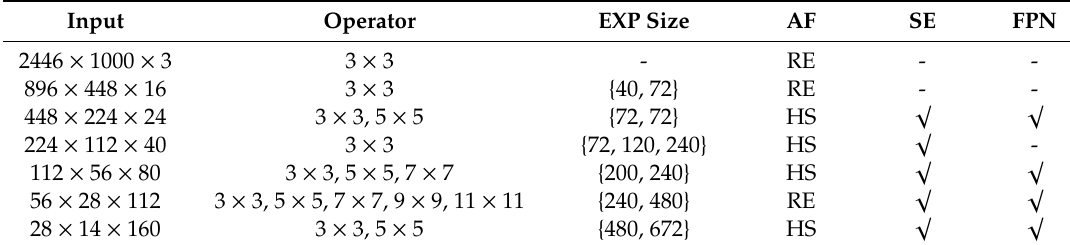
Table 2. Specification for mixed convolution (MC) backbone.